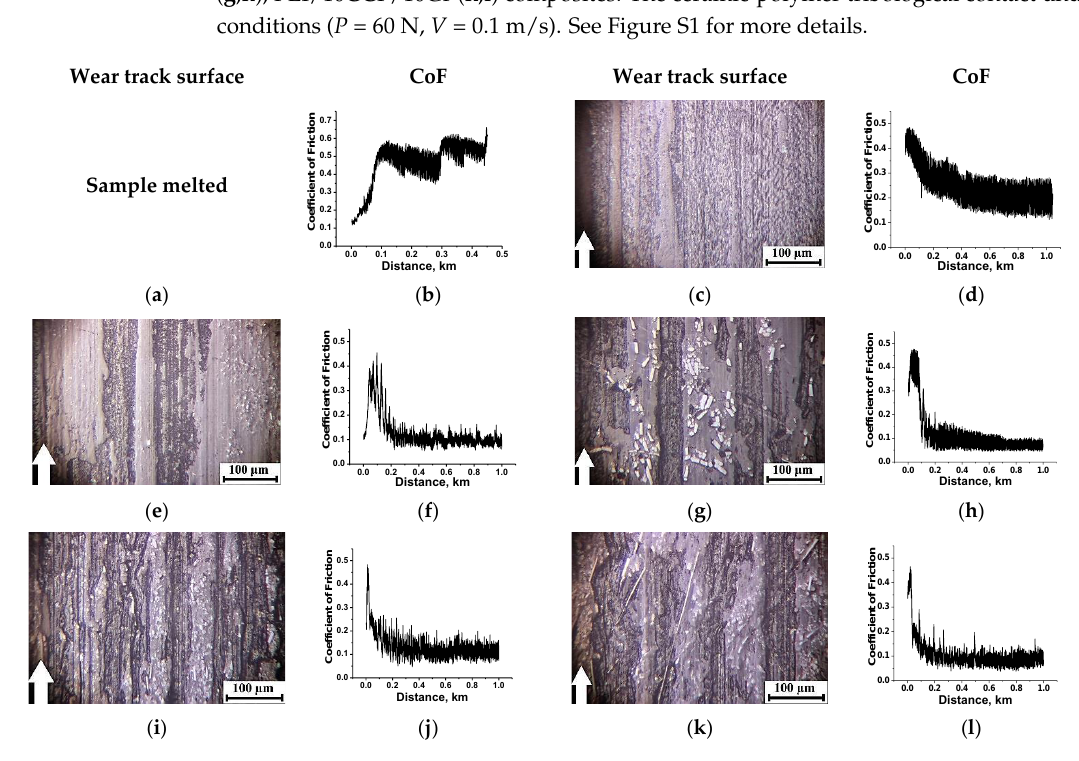
Figure 3. The optical micrographs of the wear track surfaces and the CoF time dependences for both neat PI ( a , b ) and PEI ( c , d ), as well as their PI/10CCF ( e , f ), PI/10CCF/10Gr ( i , j ), PEI/10CCF ( g , h ), PEI/10CCF/10Gr ( k , l ) composites. The ceramic-polymer tribological contact under the ‘severe’ conditions ( P = 180 N, V = 0.5 m/s). See Figure S2 for more details. In regard to three-component composites, it was shown that loading with Gr was almost equally as efficient for both types of matrices. Both WR and CoF levels, as well as surface R a roughness, were close in magnitude (Figure 3j, l). Note that the ‘severe’ tr ibo- logical conditions prevented the formation of a continuous uniform TL (Figure 3i,k). Thus, it was the ability to form and adhere a TL that determined the antifriction proper- ties of the two- and three-component composites based on both PI and PEI thermoplastic matrices in the ceramic- polymer tribological contact under the ‘severe’ conditions. In the cases of the PI/10CCF, PEI/10CCF, PI/10CCF/Gr and PEI/10CCF/Gr composites, the TL formation patterns were of similarity. 2.2. The Metal-Polymer Tribological Contact Changing the counterpart material on the metal one could be accompanied by the following variations in the test conditions. Firstly, the steel counterface well dissipated heat from the tribological contact zone due to its high thermal conductivity. Secondly, the steel counterpart could be damaged by friction against CCFs. Thirdly, the ball bearing steel was more chemically reactive towards the polymers, especially under the ‘severe’ tribological conditions. This fact was reflected in dependences of the tribological charac- teristics from the P V product (Figure 4). The following identified features should be noted. Firstly, there were high WR values for both neat PI and PEI even under the ‘ mild ’ tribological conditions, but it was several times higher for neat PI compared to that for